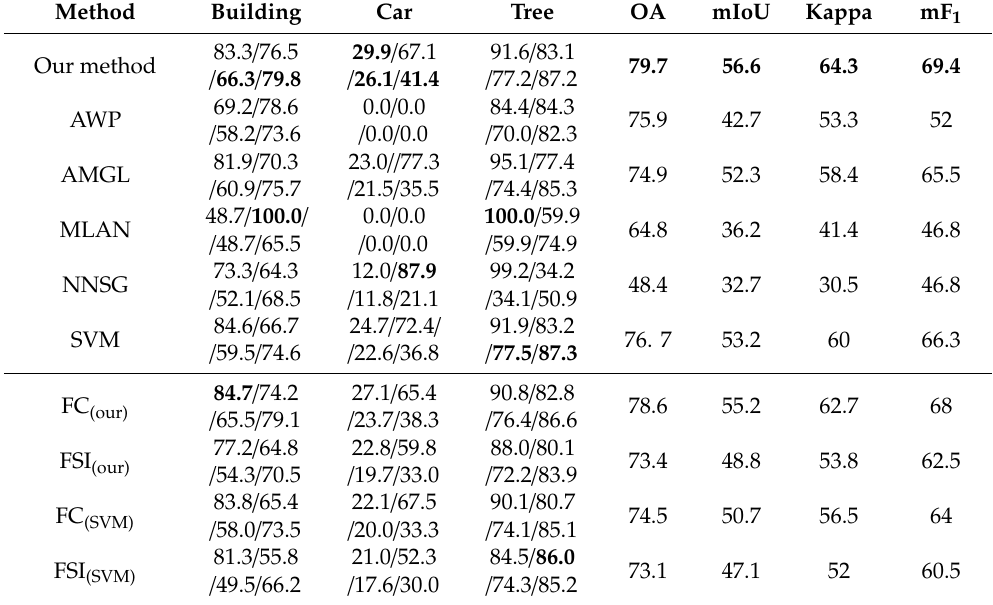
Table 8. Classification results of Scene2 (%). Precision / recall / intersection over union (IoU) / F 1 -score, OA, mIoU, Kappa and mF 1 (%). Note that the highest accuracy values are highlighted in